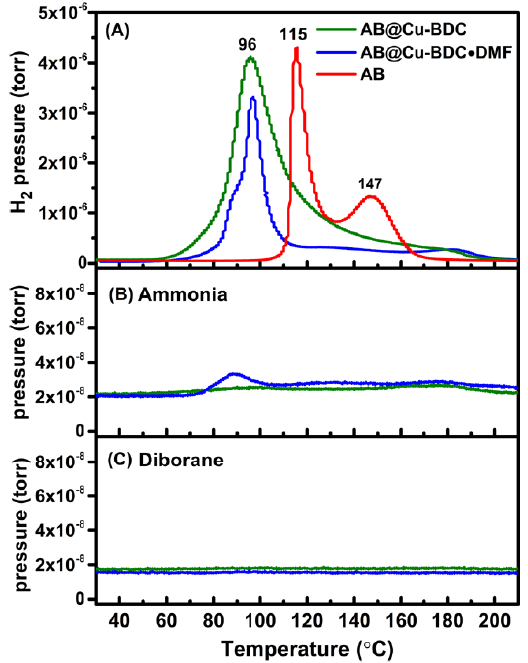
Figure 17. Temperature-programmed desorption with mass spectroscopy (TPD-MS) of ( A ) hydro- gen, ( B ) ammonia and ( C ) diborane generated from AB (red), AB@Cu-BDC (green) and AB@Cu- BDC · DMF (blue) in the unit of Torr. Reprinted with permission from [288]. Copyright (2019), American Chemical Society.